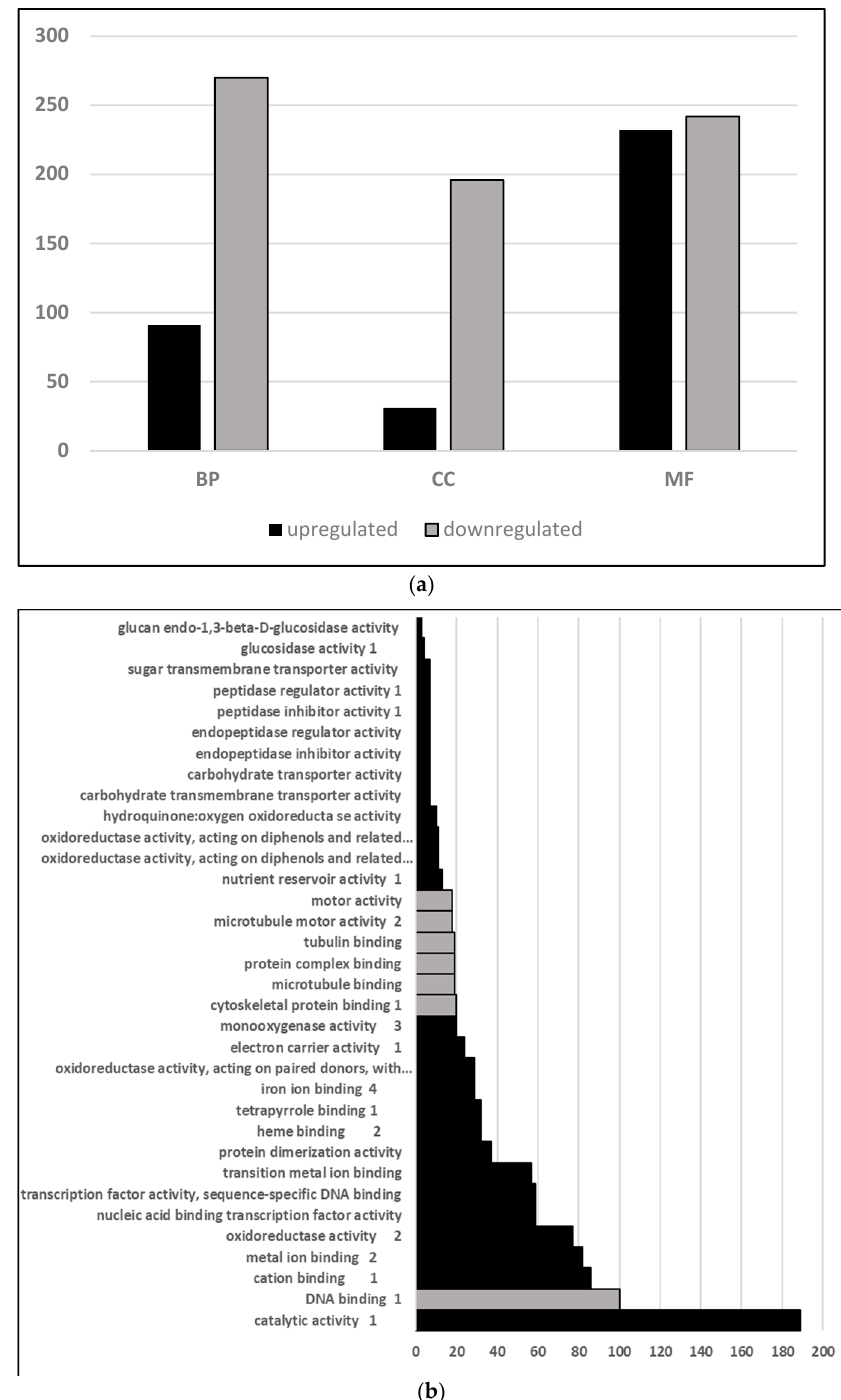
Figure 1. ( a ). Biological processes (BP), cellular component (CC), and molecular function (MF) gene ontology categorization of differentially expressed genes in V. riparia buds. Bars represent the gene ontology of non-redundant differentially expressed genes upregulated (black) and downregulated (gray) in SD relative to LD buds. ( b ) Molecular function categories enriched in upregulated (black) and down (gray) differentially expressed genes.